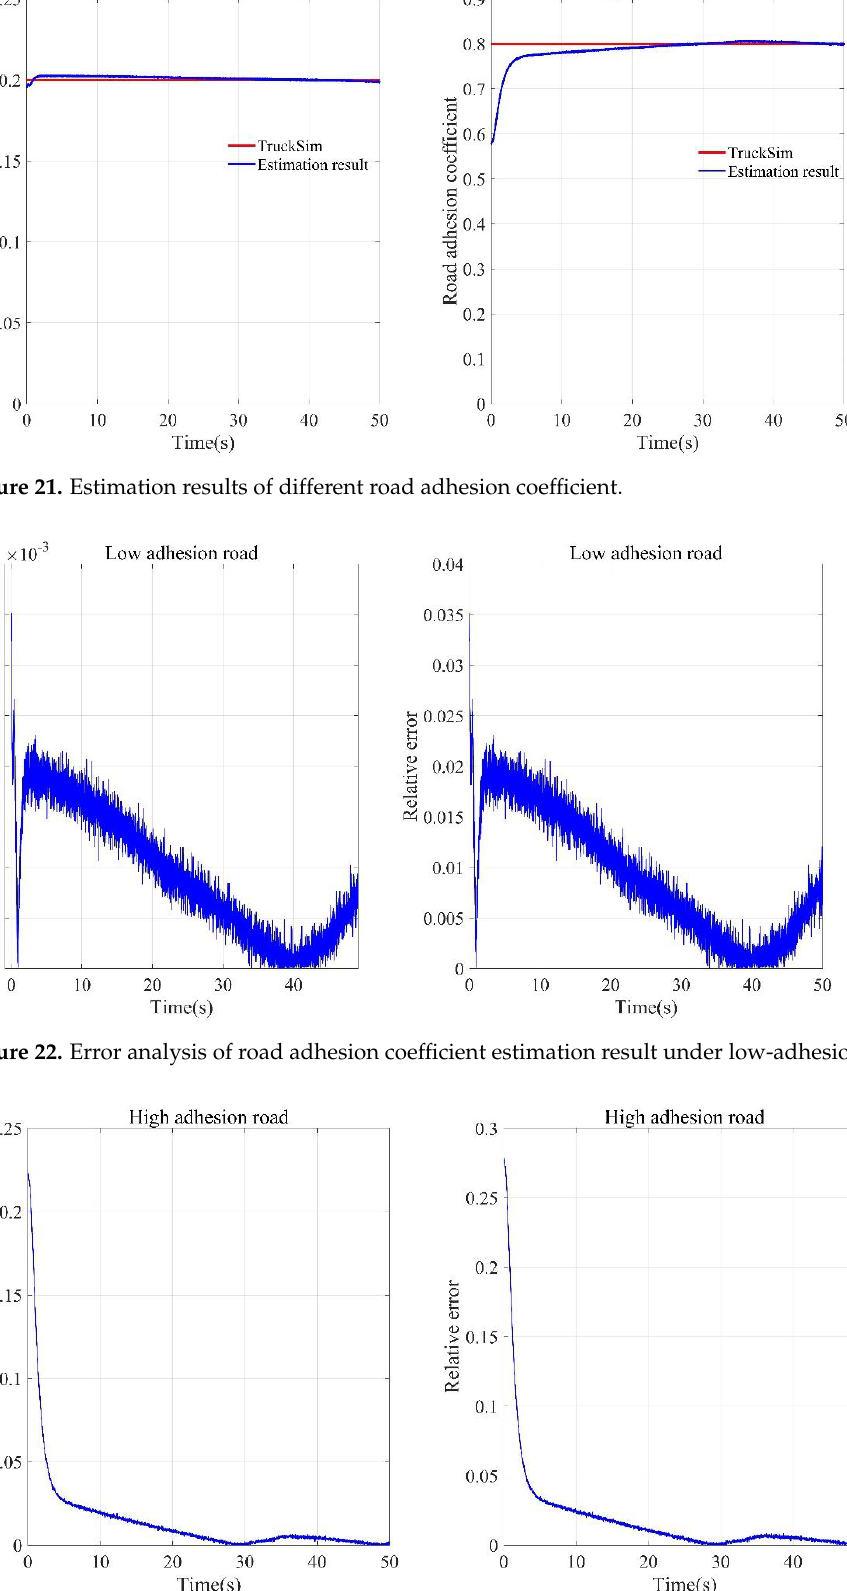
Figure 23. Error analysis of road adhesion coefficient estimation result under high-adhesion road.